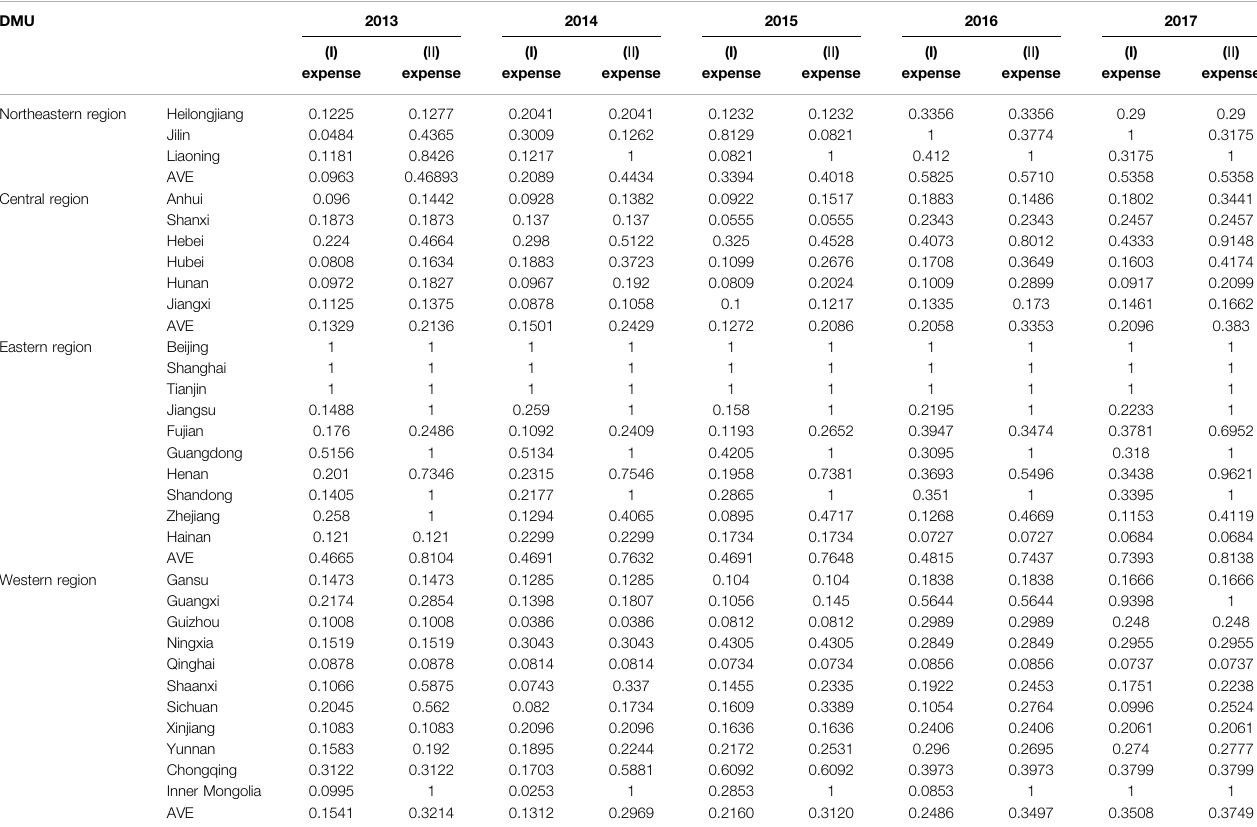
TABLE 3 | Input ef fi ciency level of wastewater treatment in various regions of China from 2013 to 2017. DMU